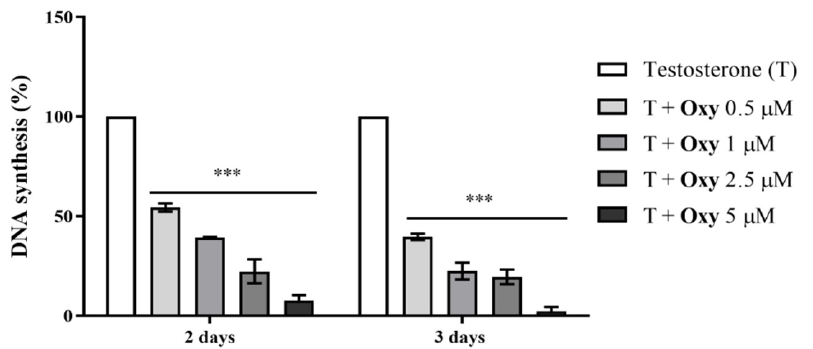
Figure 2. Effects of Oxy on proliferation (rate of DNA synthesis) of sensitive breast cancer cells. MCF-7aro cells stimulated with T (1 nM) were treated with different concentrations of Oxy (0.5–5 µ M),